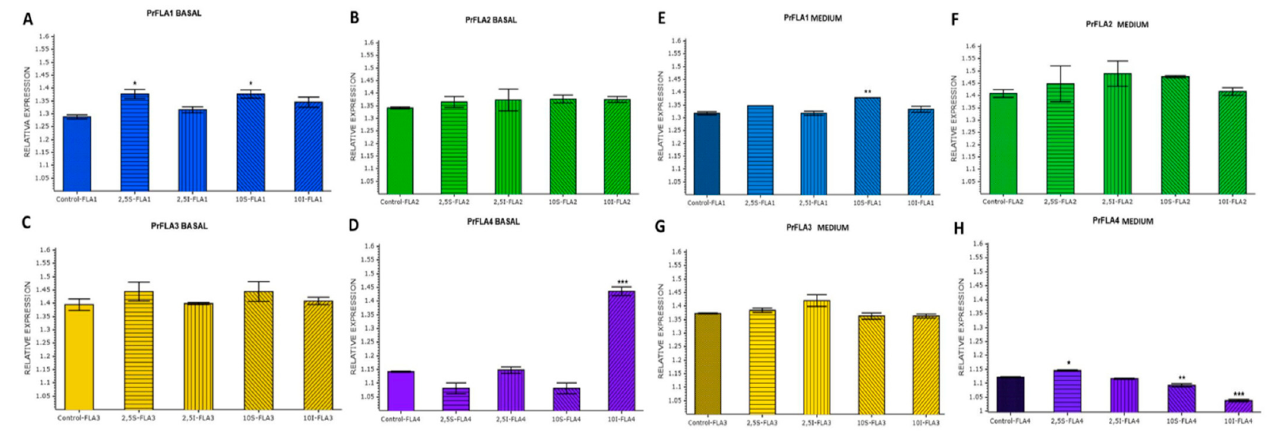
Figure 7. Relative expression of gene from group A in phylogenic. Comparison of basal and medium cut of stem on radiata pine seedlings, at different time and stem side (Control or Time 0, 2.5 h S (upper stem side), 2.5 h I (lower stem side), 10 h S (upper stem side), 10 h I (lower stem side)). ( A ) PrFLA1 relative expression in basal cut samples. ( B ) PrFLA2 relative expression in basal cut samples. ( C ) PrFLA3 relative expression in basal cut samples. ( D ) PrFLA4 relative expression in basal cut samples. ( E ) PrFLA1 relative expression in middle cut samples. ( F ) PrFLA2 relative expression in middle cut samples. ( G ) PrFLA3 relative expression in middle cut samples. ( H ) PrFLA4 relative expression in middle cut samples. Asterisks indicate statistical significance between control and sample at each sampling time (* p < 0.05, ** p < 0.01, *** p < 0.001, Student´s t -test).